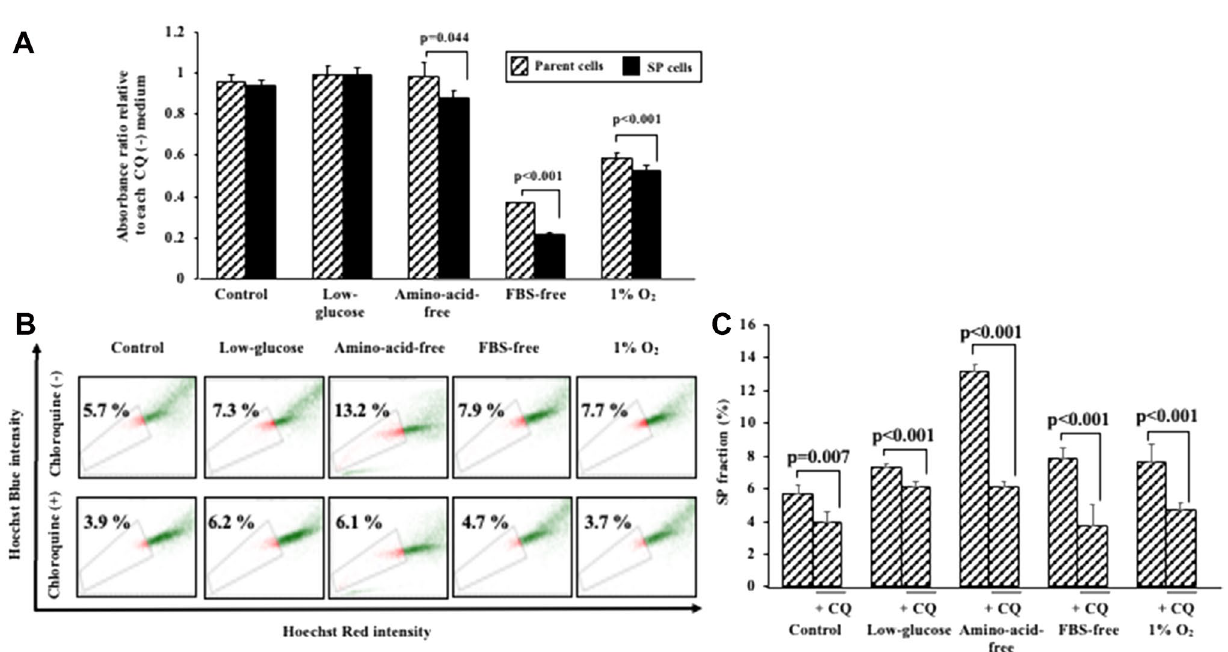
Figure 8. The cytotoxicity of the autophagy inhibitor on OCUM-12 cells. ( A ) The cytotoxicity of the autophagy inhibitor on the parent OCUM-12 cells and the OCUM-12/SP cells. Chloroquine (CQ) significantly decreased the viability of the OCUM-12/SP cells under amino-acid-free medium, FBS-free medium, and 1%O 2 conditions (absorbance ratio relative to each CQ(−) medium; 0.88 and 0.99; p = 0.044, 0.21 and 0.37; p < 0.001, 0.53 and 0.59; p < 0.001, respectively). ( B ) Effect of the autophagy inhibitor on the SP fraction of OCUM-12 under starvation and hypoxic stress. The SP fraction was decreased under all conditions including in the control medium following the addition of CQ. ( C ) The SP fraction in the OCUM-12 cells was significantly reduced with CQ under amino-acid-free medium (13.2% to 6.1%), FBS-free medium (7.9% to 3.7%), and 1%O 2 conditions (7.7% to 4.7%) compared to the control